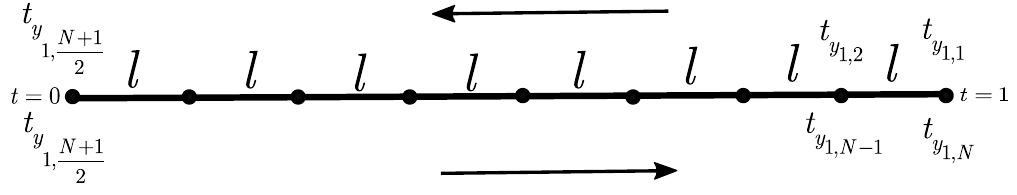
Figure 2. Definition of the parameter t used in the Bezier curve.